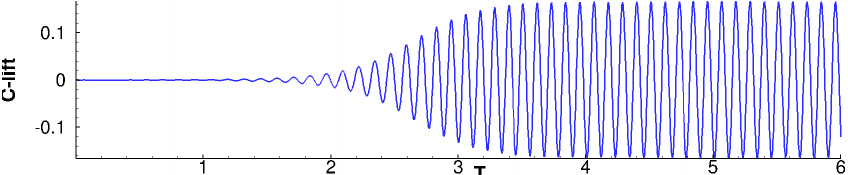
Figure 5. Re D = 60 cylinder flow: Evolution of lift coefficient C l from equilibrium steady solution to the limit cycle.